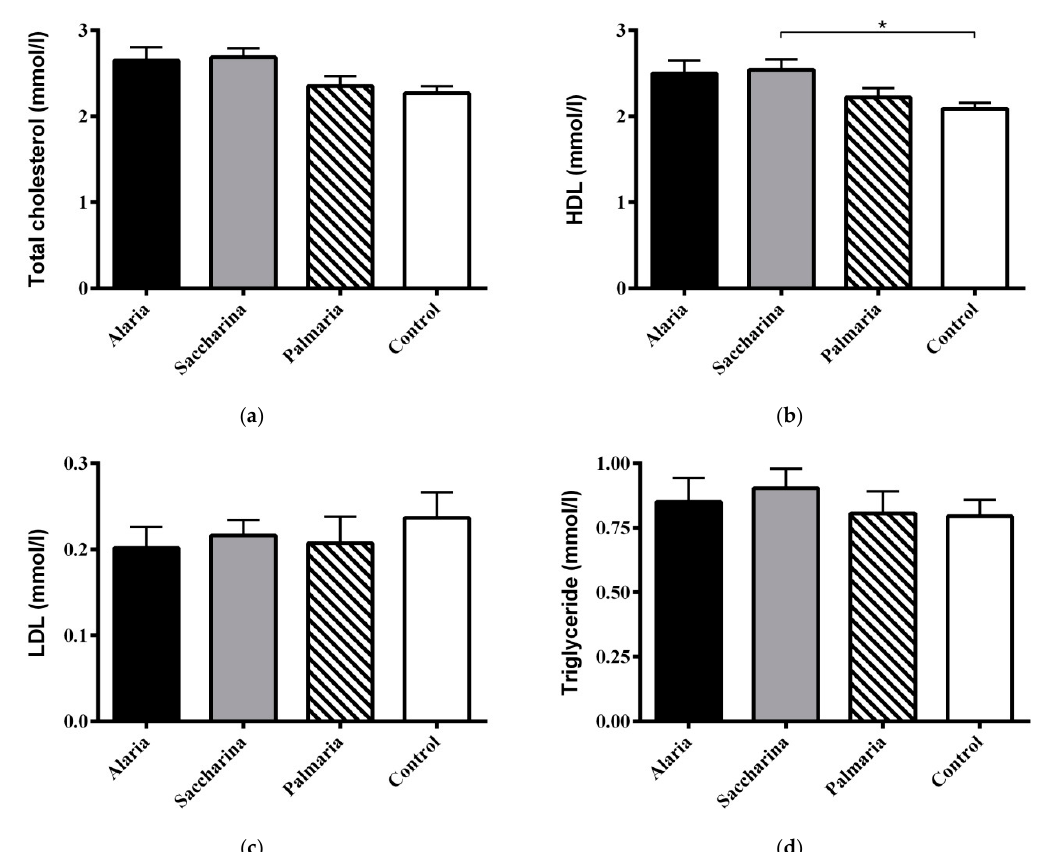
Figure 4. ( a ) Total plasma cholesterol, ( b ) HDL cholesterol, ( c ) LDL cholesterol, and ( d ) plasma triglyceride levels from the KK-Ay mice at the end of the 11-week intervention with diets supplemented with Alaria esculenta , Saccharina latissimi , or Palmaria palmata compared to chow (control). No significant differences were found for total and LDL cholesterol and triglyceride levels. Plasma HDL was higher for the Saccharina group compared to control * ( p < 0.05). Values are means ± SEM.